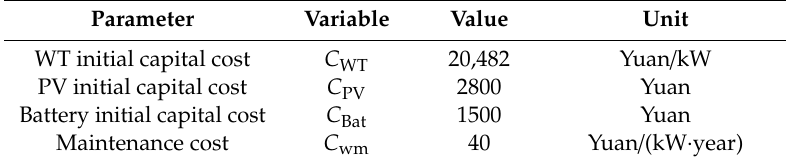
Table 3. The costs for the system components. PV: photovoltaic power and WT: wind turbine.